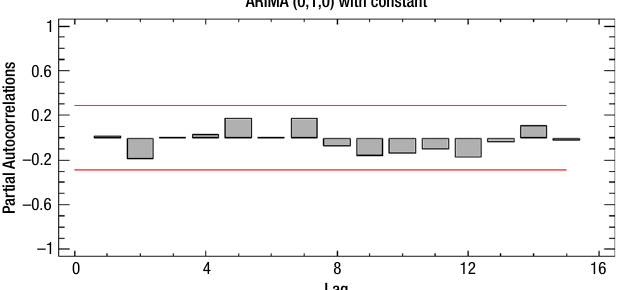
Fig. 16b. Residual partial autocorrelations for adjusted time series of annual Argentinian